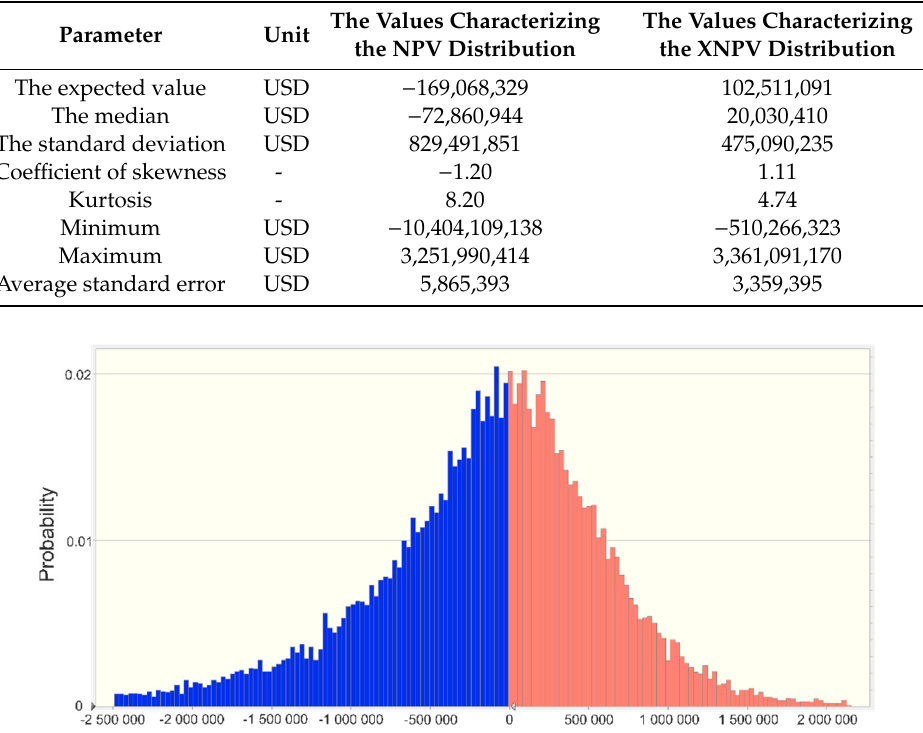
Table 3. The distribution parameters of the projected variables of NPV and XNPV.